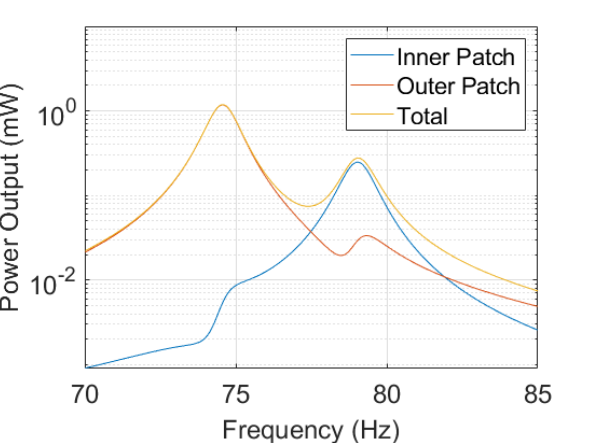
Figure 9. Maximum power output of the structure at optimal load value computed from values presented in Figure 8. Both outer patches are connected in parallel. The total power output is computed as the sum of both